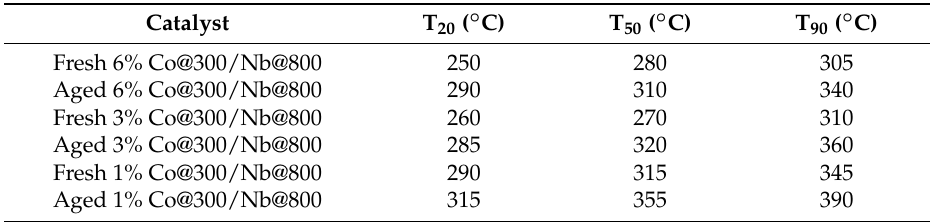
Table 4. Co@300/Nb@800 with various cobalt loadings for propane oxidation: fresh and aged.